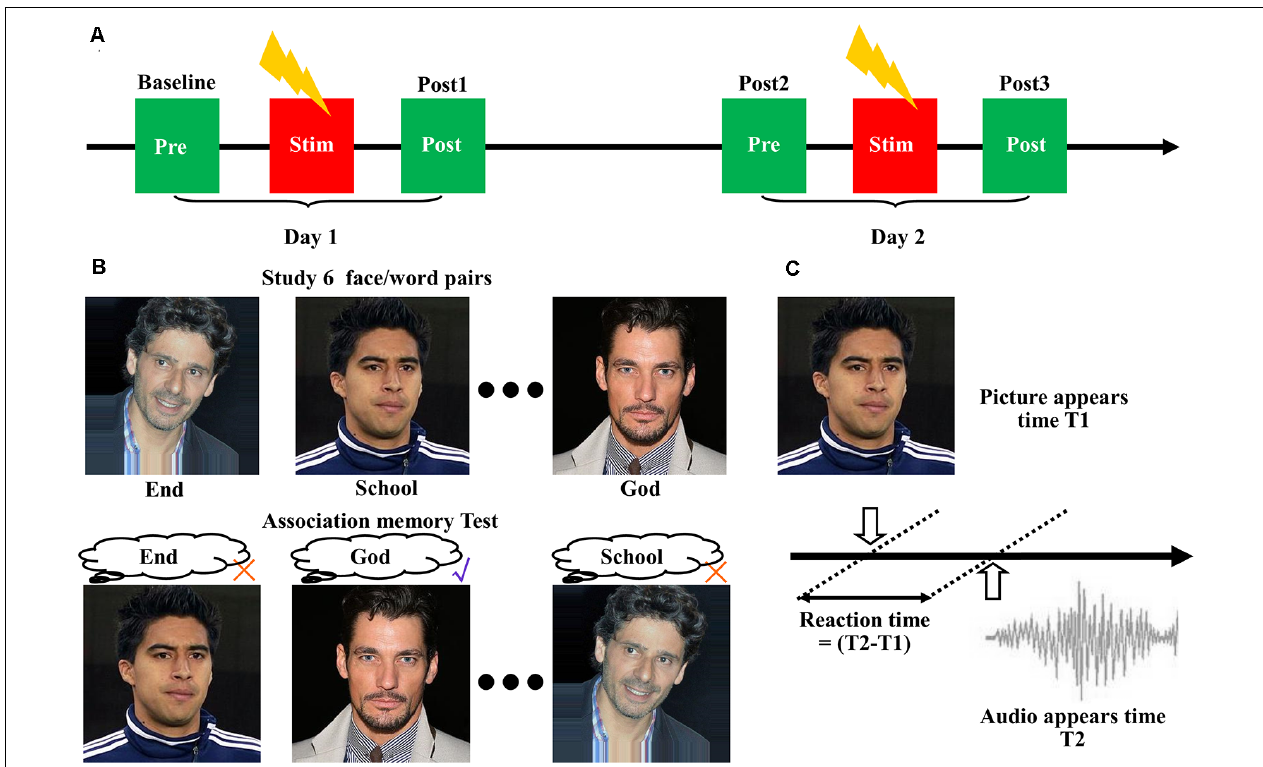
FIGURE 1 | Cortico-hippocampal brain connectivity-guided repetitive transcranial magnetic stimulation (rTMS) improved associative memory. (A) Experimental procedures. The subjects received four treatments at the three stimulation targets, plus one sham stimulation. Each treatment lasted for 2 days, and associative memory performance was measured at the following time points: before stimulation on the first day (baseline), after stimulation on the first day (post 1), before stimulation on the second day (post 2), and after stimulation on the second day (post 3). Each pair of treatments was separated by at least 5 days to reduce the after-effects. (B) Design of the face-cued word recall measure of associative memory. (C) Schematic representation of reaction time extraction.